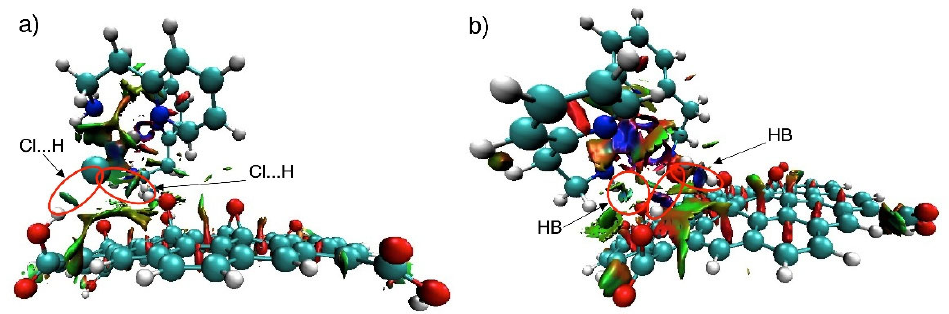
Figure 10. Three-dimensional isosurface plot of ( a ) Zn1 /GO and ( b ) Zn3 /GO, the reduced density. Figure 10. Three ‐ dimensional isosurface plot of ( a ) Zn1/GO and ( b ) Zn3 /GO, the reduced density.